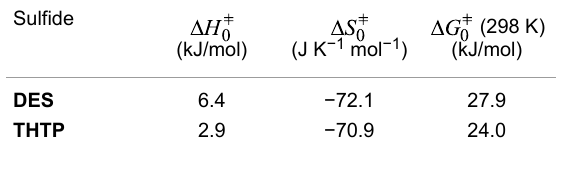
Table 1: Activation parameters (enthalpy entropy and free energy at room temperature (298K)) for the self-exchange reactions of diethyl sulfide DES and tetrahydrothiophene THTP with their respective radical cations in